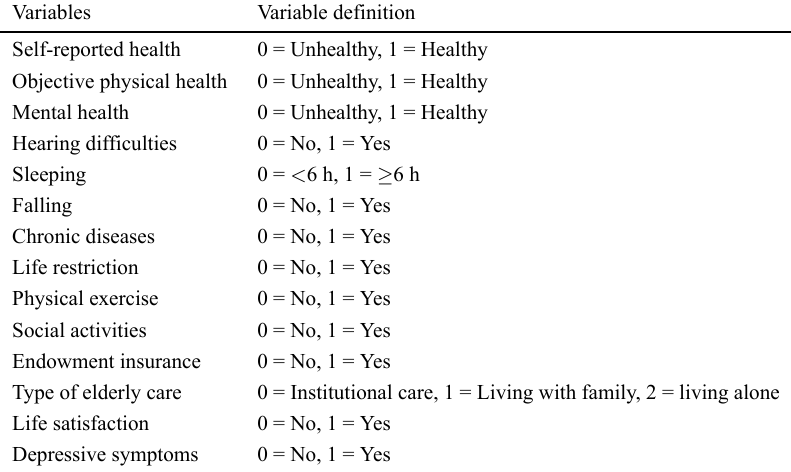
Table 1. Descriptive statistics of variables (n =